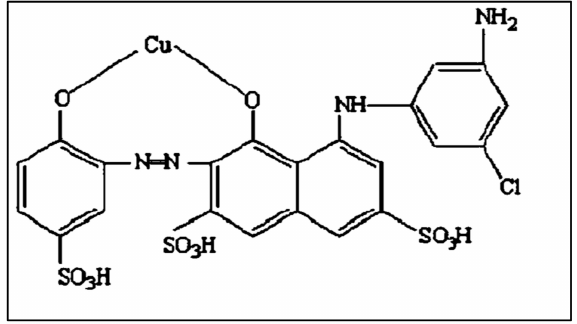
Figure 13. Structure of ismate violet